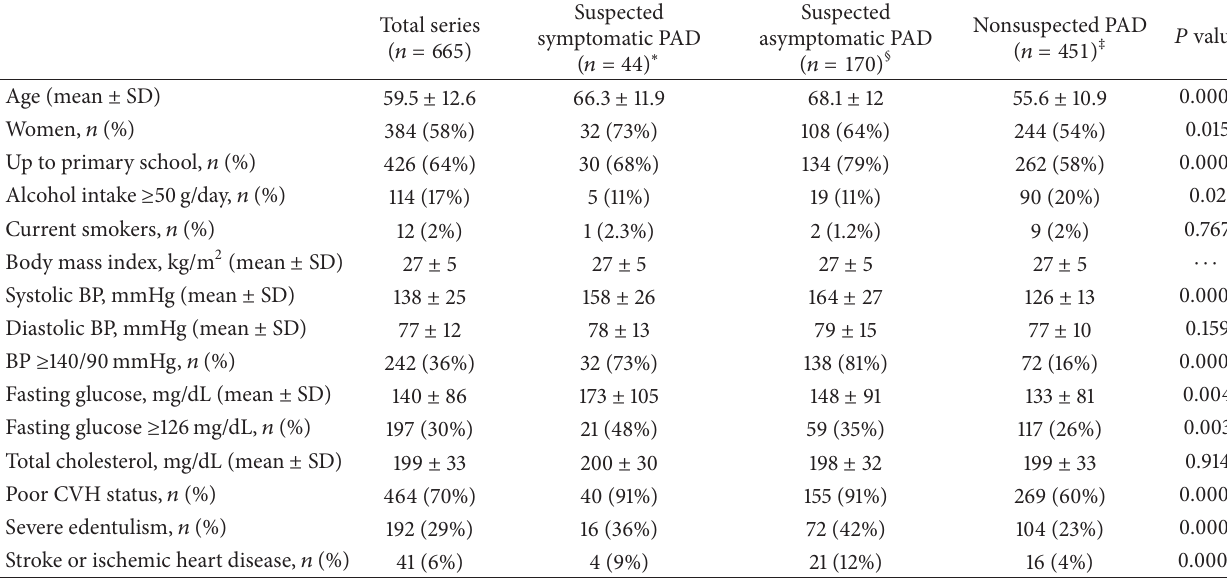
Table 6: Characteristics of Atahualpa residents aged ≥ 40 years according to the categories of peripheral artery disease (PAD)